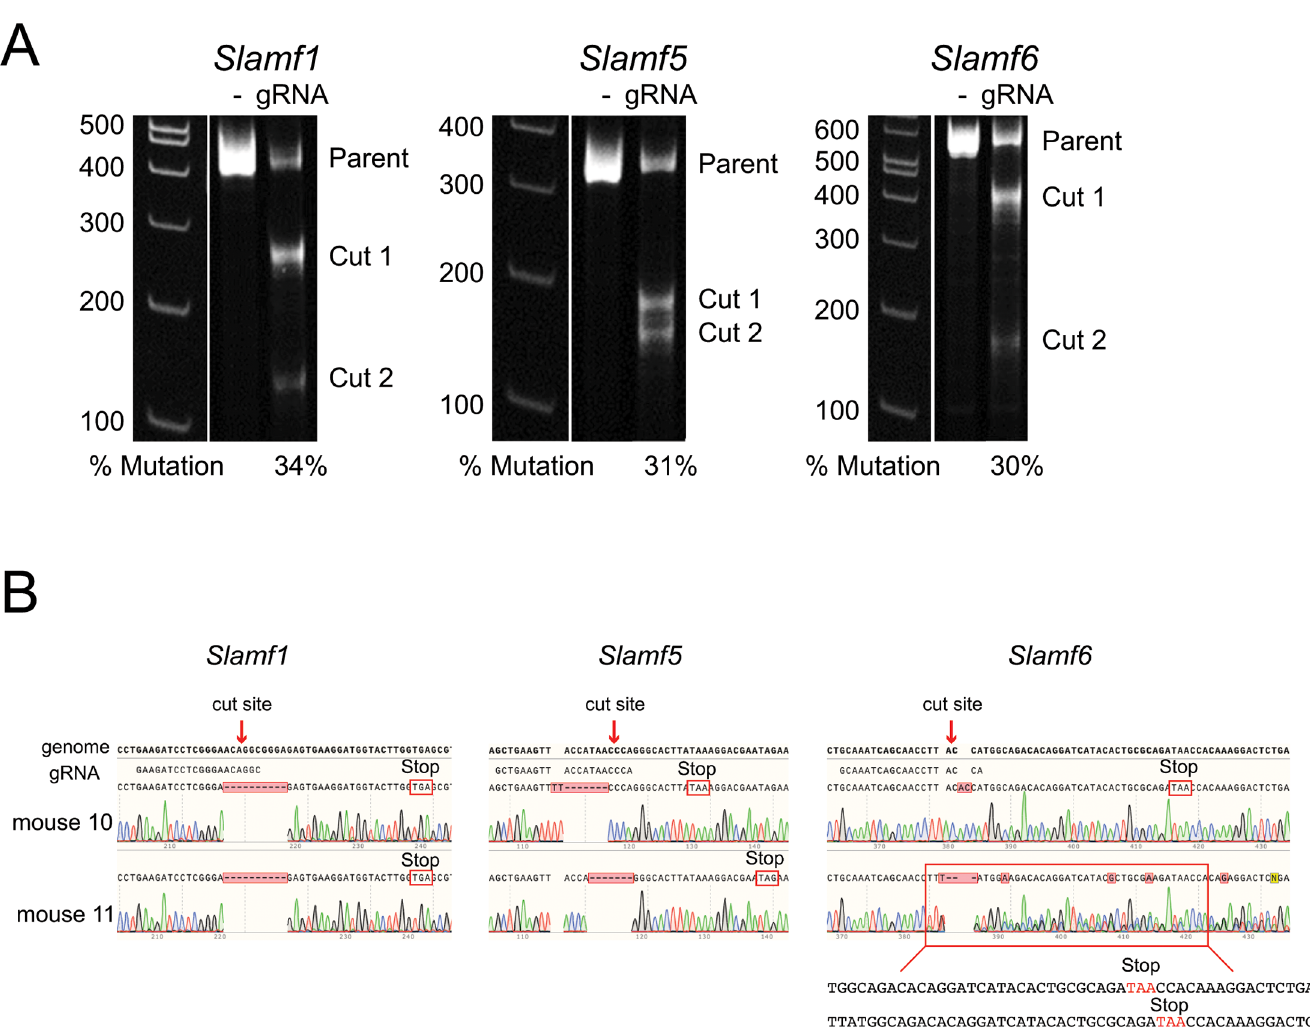
Fig 1. Generation of Slamf1 , 5 , 6 Δ / Δ mice using CRISPR-Cas9 technology. (A) Surveyor assay performed to determine mutation efficiency in mouse N2A cells that were transfected with gRNA expressing pBT-U6-Cas9-2A-GFP vectors. Gel shows comparison between the original gene product (parent) and the mutated gene products (cut 1, cut 2). One surveyor assay was performed. (B) Genotyping of Slamf1 Δ / Δ , Slamf5 Δ / Δ , Slamf6 Δ / Δ mice. Genomic DNA, guide RNA (gRNA), and sequencing results are aligned, with shaded boxes showing differences in sequence, which include deletions (dashes), insertions, and uncertain base calling that results from heterozygous mutations in each allele. The sequences of each allele of Slamf6 in mouse 11 is shown beneath the chromatogram. Each mutation leads to a stop codon shown in a red box. Genotyping was performed as indicated in Table